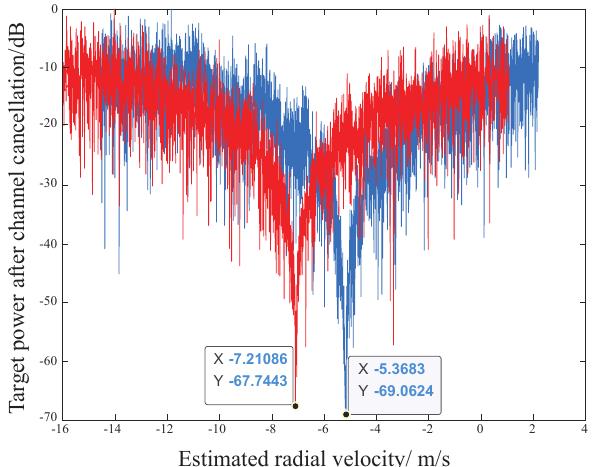
Figure 18. The estimated results of the radial velocities of our moving vehicles by the proposed